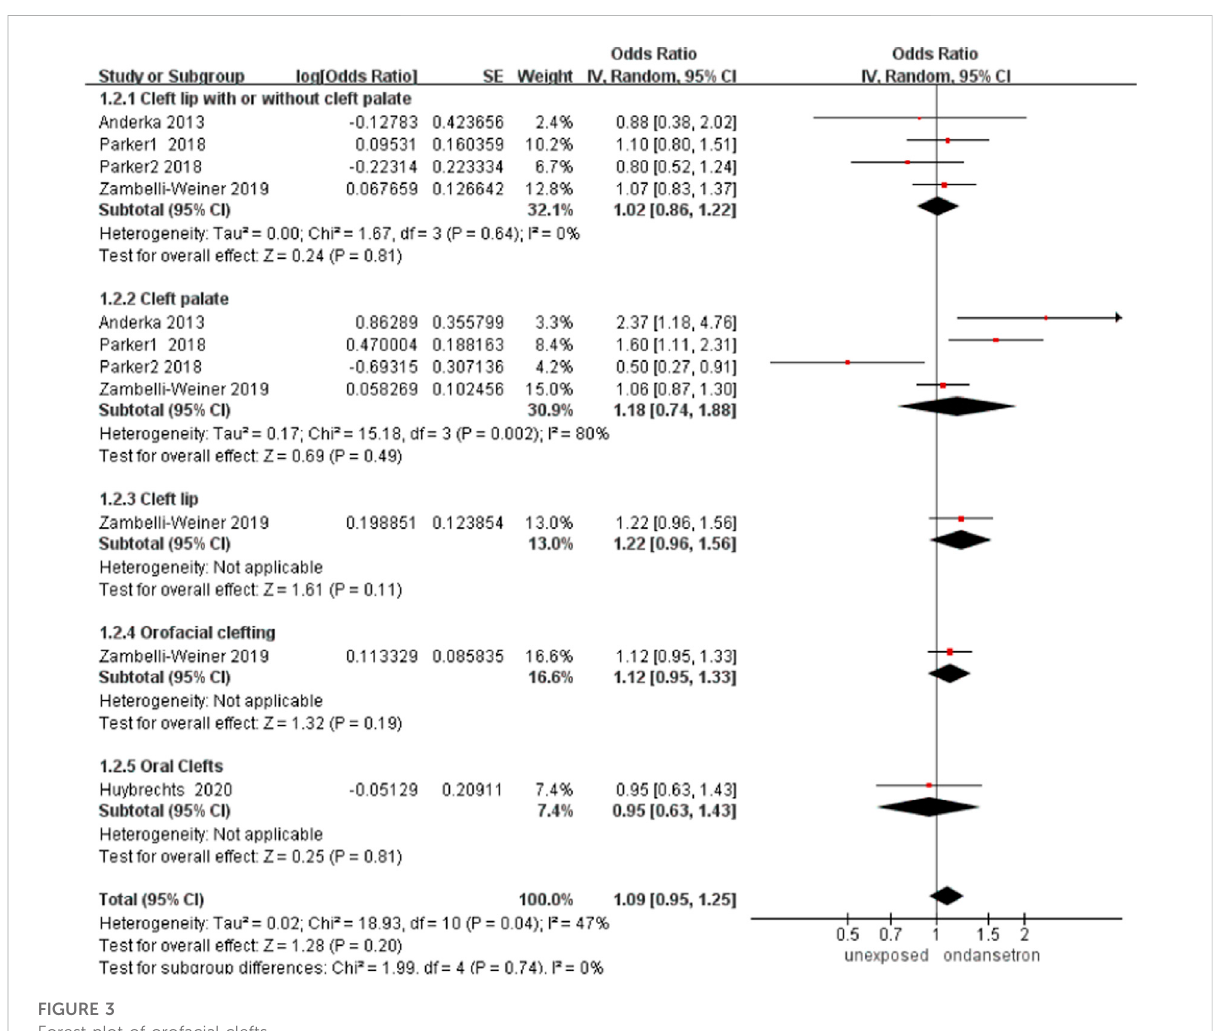
FIGURE 3 Forest plot of orofacial